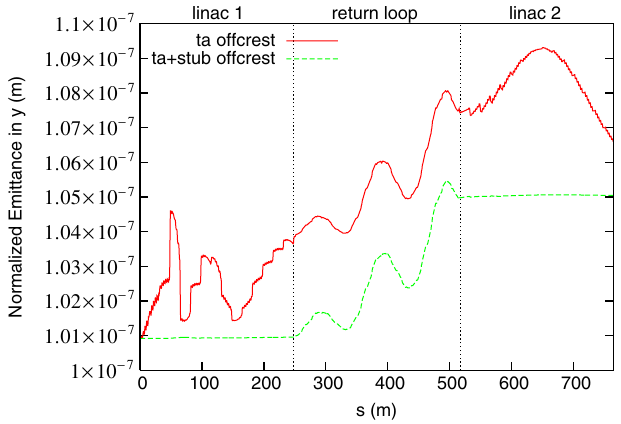
FIG. 8. (Color) Emittance growth with off-crest operation with and without symmetrizing